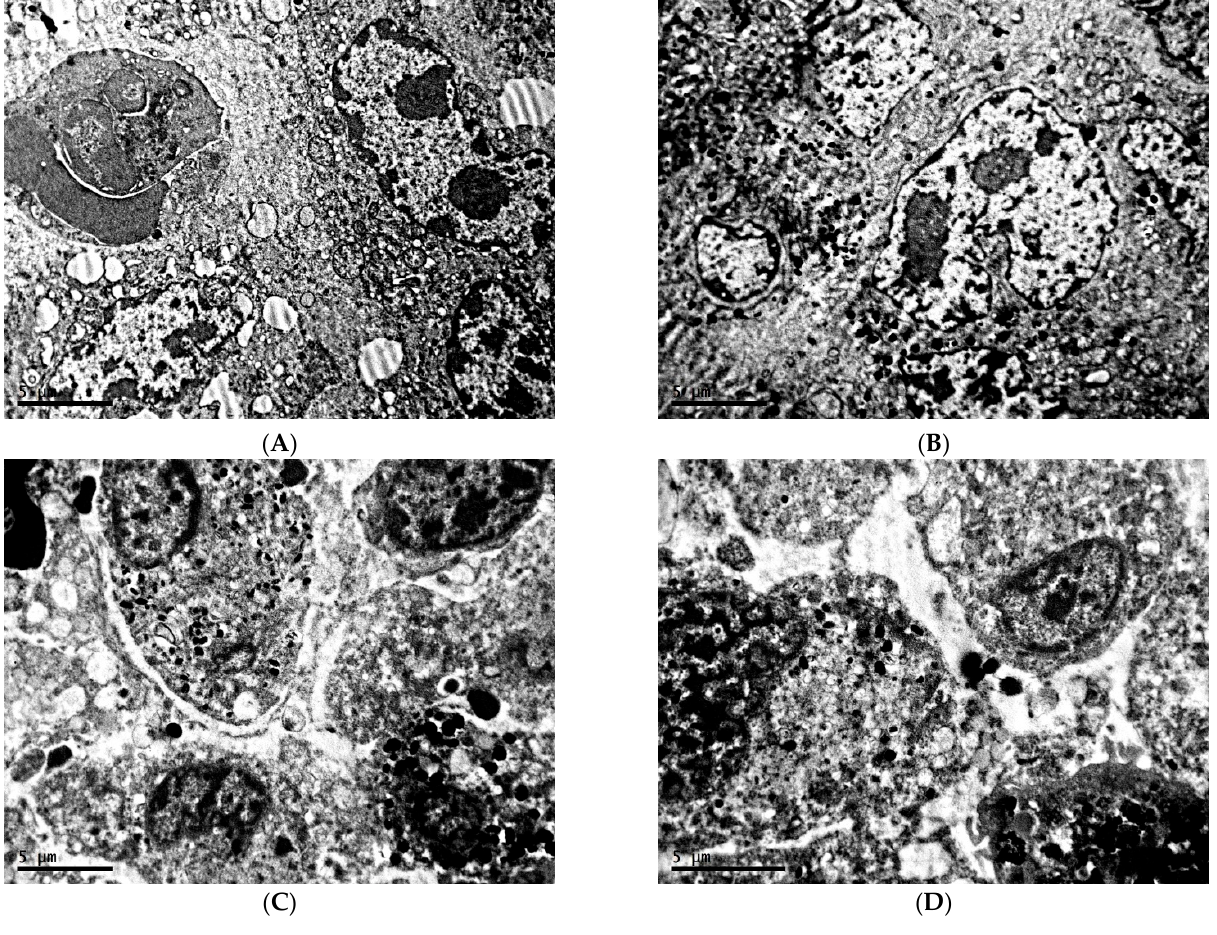
Figure 1. Morphological condition of tissue of transplantable malignant melanoma B16 under the influence of fixed light regime. TEM, ( A – D )—×6700.